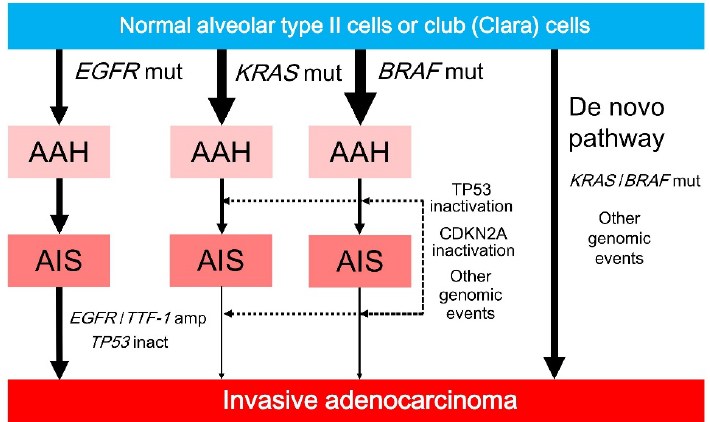
Figure 4. AAH develops from normal alveolar type II cells or club (Clara) cells after mutations in EGFR , KRAS , and BRAF . EGFR -mutated AAH progresses to AIS, followed by invasive adenocarcinoma after EGFR / TTF-1 amplification. KRAS - or BRAF -mutated AAH rarely progresses to AIS or invasive adenocarcinoma, but can do so after the inactivation of TP53/CDKN2A (p16) or other genomic events (dotted arrows). KRAS - or BRAF -mutated invasive adenocarcinoma may arise from normal lung epithelium via a de novo pathway that involves KRAS or BRAF mutations and other genomic events. Solid arrows indicate progression. AAH, atypical adenomatous hyperplasia; AIS, adenocarcinoma in situ; amp, amplification; inact, inactivation; mut, mutation.